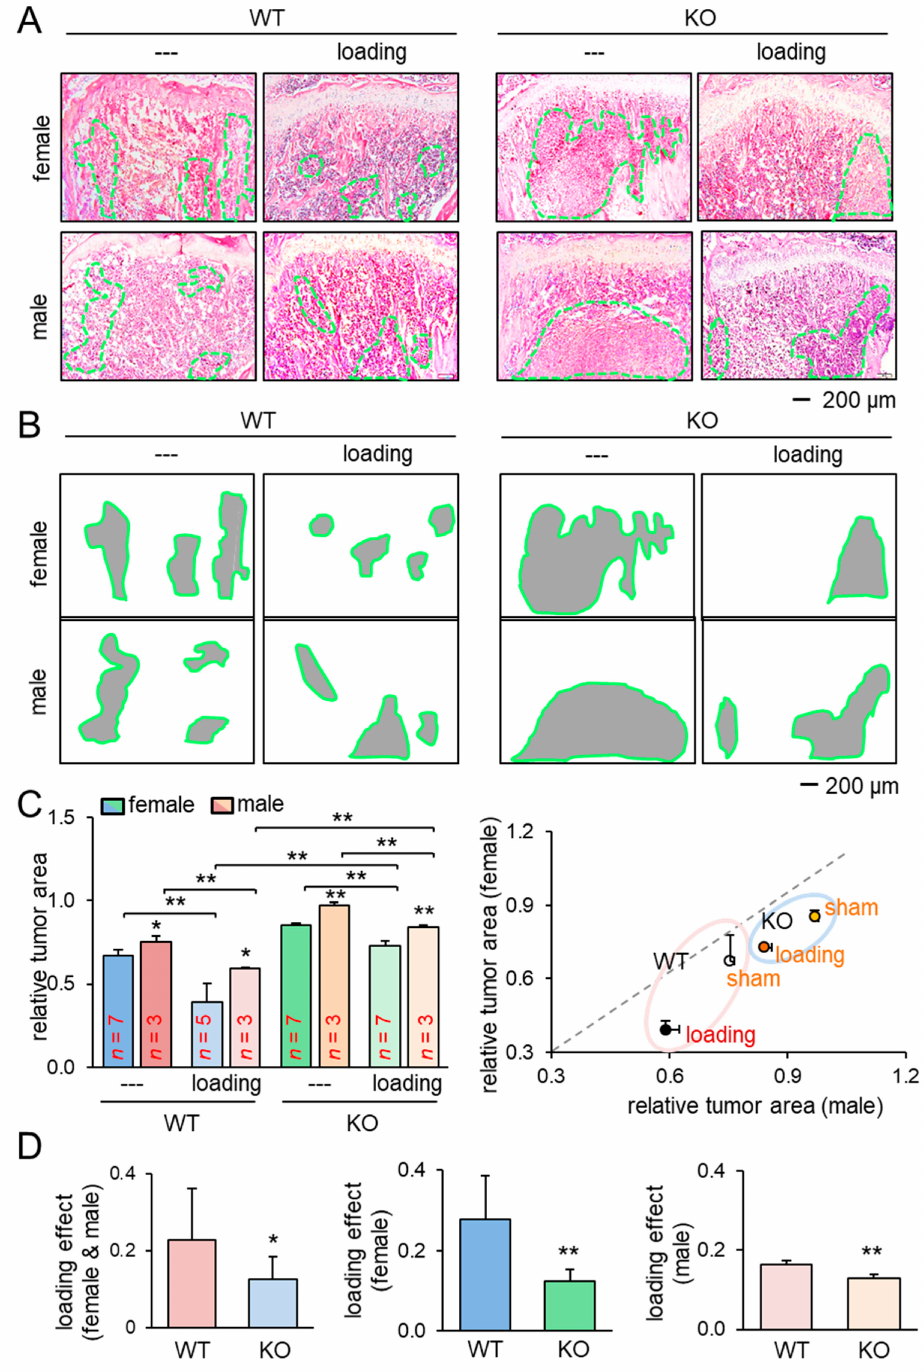
Figure 2. Reduction of the tumor-invaded area by knee loading. KO = knockout, and WT = wild-type. The single and double asterisks indicate p < 0.05 and p < 0.01, respectively. ( A , B ) H&E-stained histological images of the proximal tibiae of the wild-type and knockout mice with and without knee loading, and the region of the tumor-invaded area. ( C ) Comparison of the relative tumor area in the proximal tibiae for female and male mice. ( D ) Comparison of the loading effects on tumor areas between wild-type and knockout mice. The first plot is for all mice, and the second and third plots are for female and male mice,